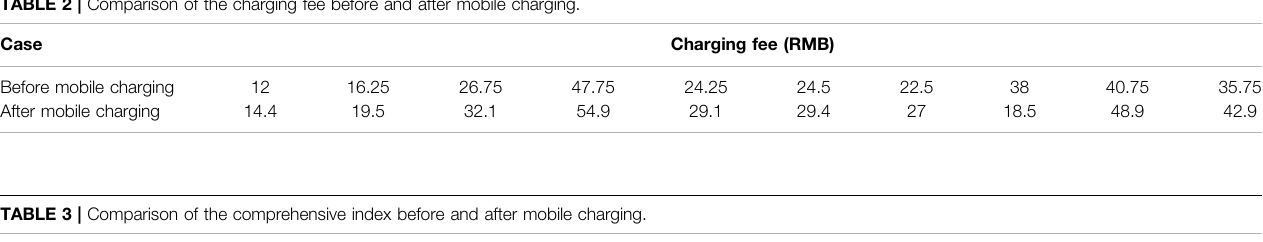
TABLE 3 | Comparison of the comprehensive index before and after mobile charging.